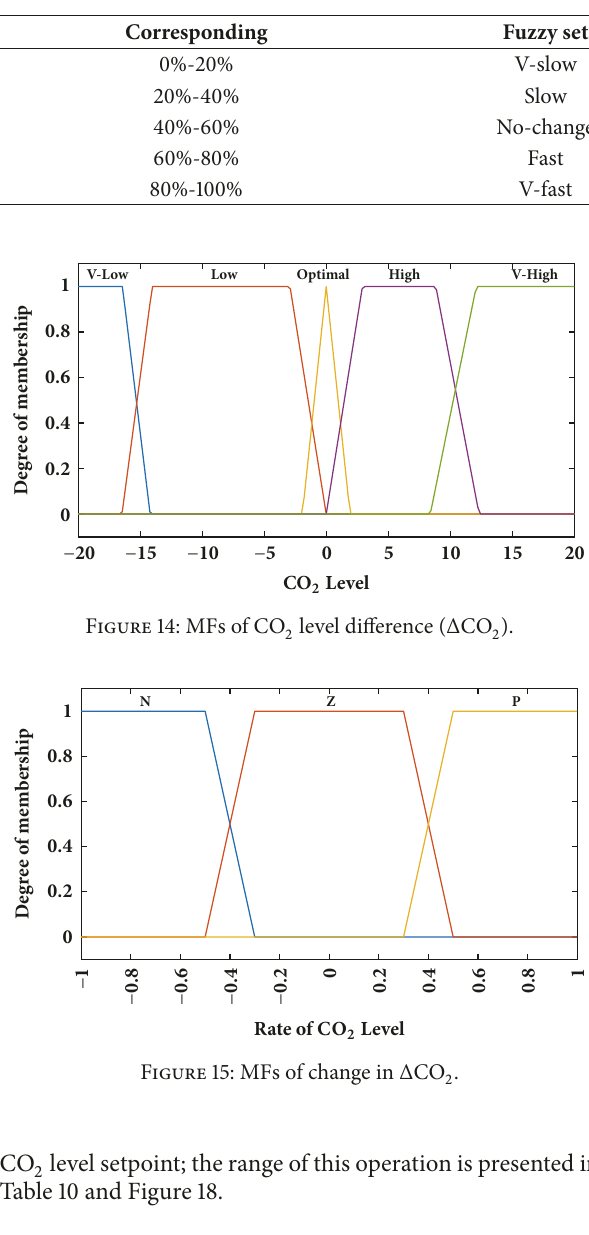
Table 9: MFs of second output.